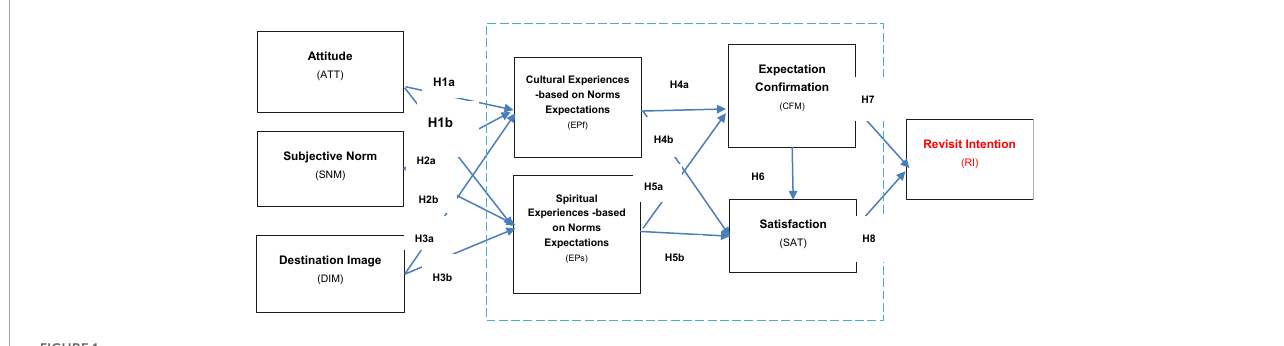
FIGURE1 Research model and hypothesis of the